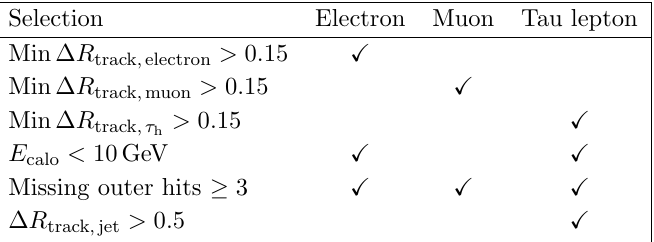
Table 2 . De(cid:12)nitions of the lepton vetoes used in the T&P studies to estimate P veto , for each (cid:13)avor of charged lepton. The criteria listed are the subset of the search criteria that are the most e(cid:14)cient at rejecting each